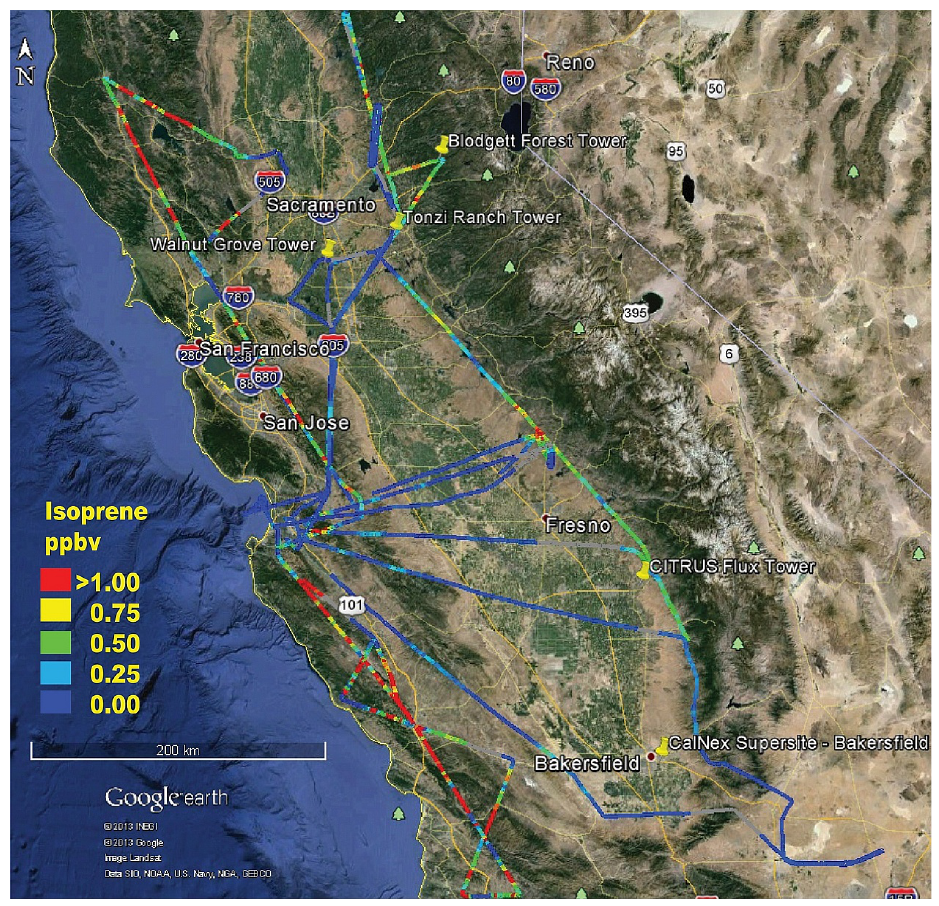
Figure 5. Spatial distributions of isoprene concentrations measured during